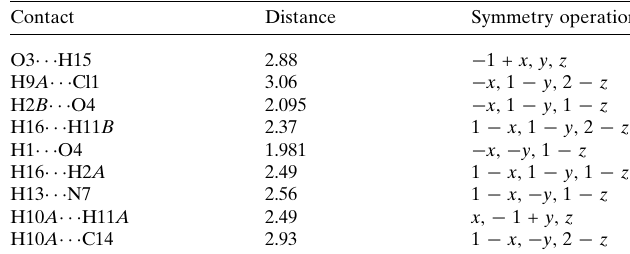
Table 2 Summary of short interatomic contacts (A˚ ) in the title compound.